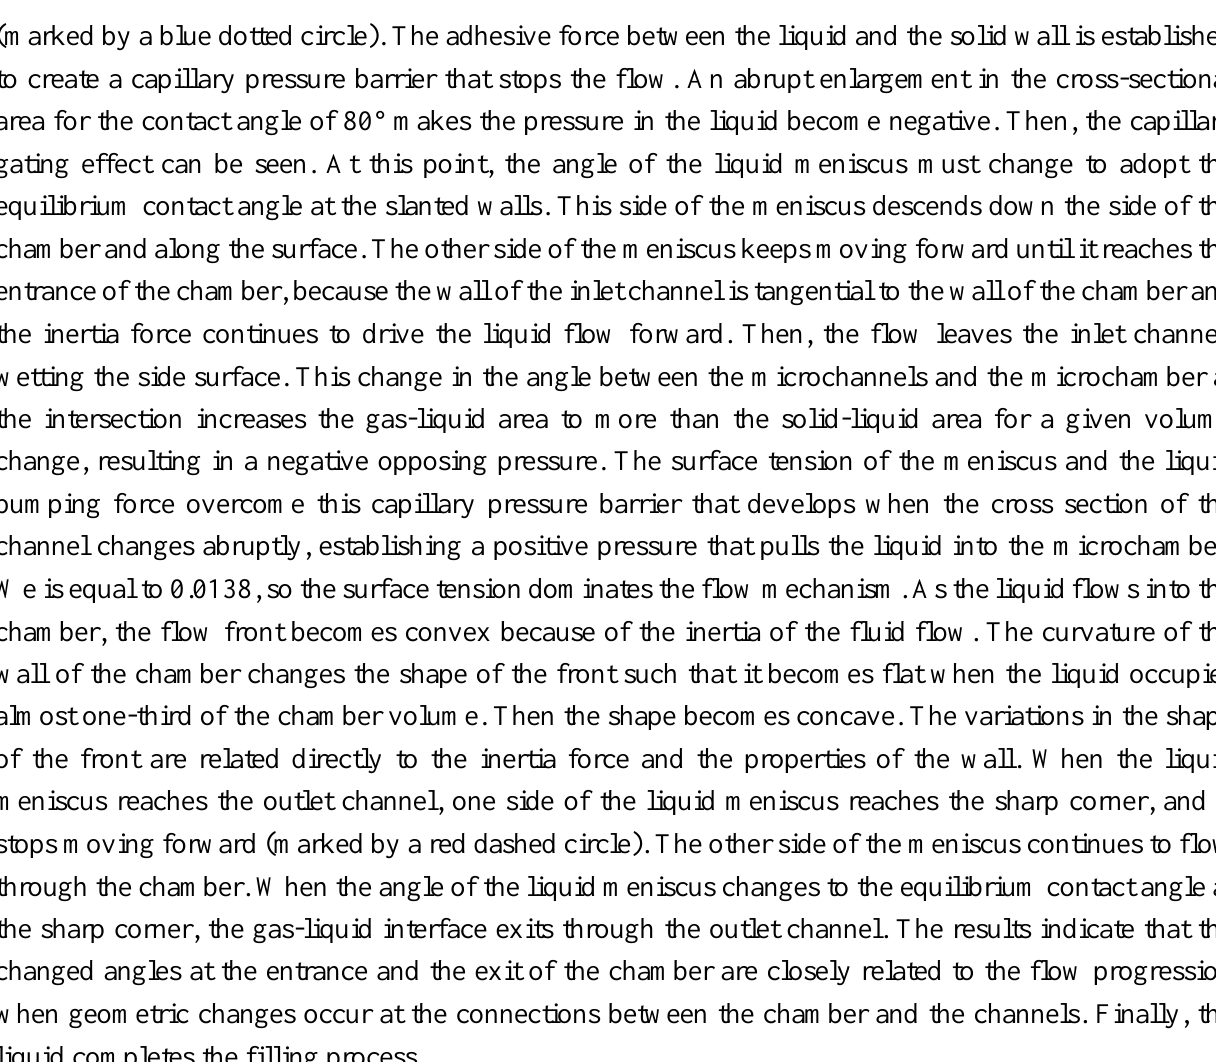
Figure 5. Filling process for inlet velocity of 0.1 m/s and θ